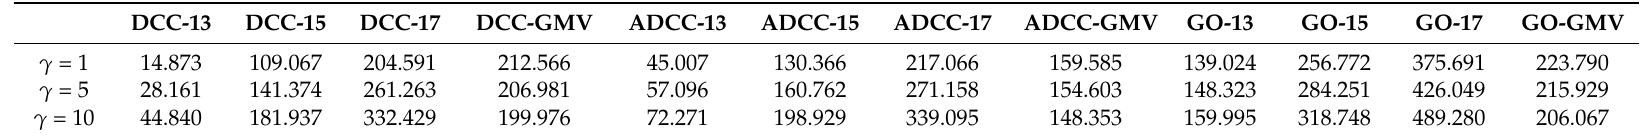
Table 6. Performance fees.